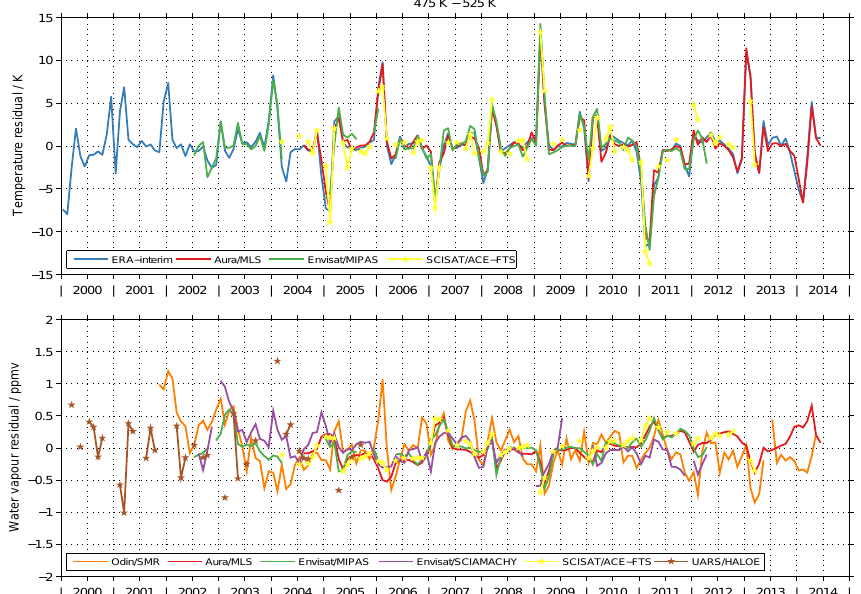
Figure 11. Anomaly of the monthly mean temperature (top) and water vapour for the polar regions at equivalent latitudes (70 to 90 ◦ N). The data were averaged within the potential temperature layers 475–525K (18–22km). Top: temperature from ERA-interim (blue), Aura/MLS (red), Envisat/MIPAS (green) and SCISAT/ACE-FTS (orange). Bottom: water vapour derived from Odin/SMR at 544GHz band (orange), Aura/MLS (red), Envisat/MIPAS (green), Envisat/SCIAMACHY (purple), SCISAT/ACE-FTS (yellow) and UARS/HALOE (brown).